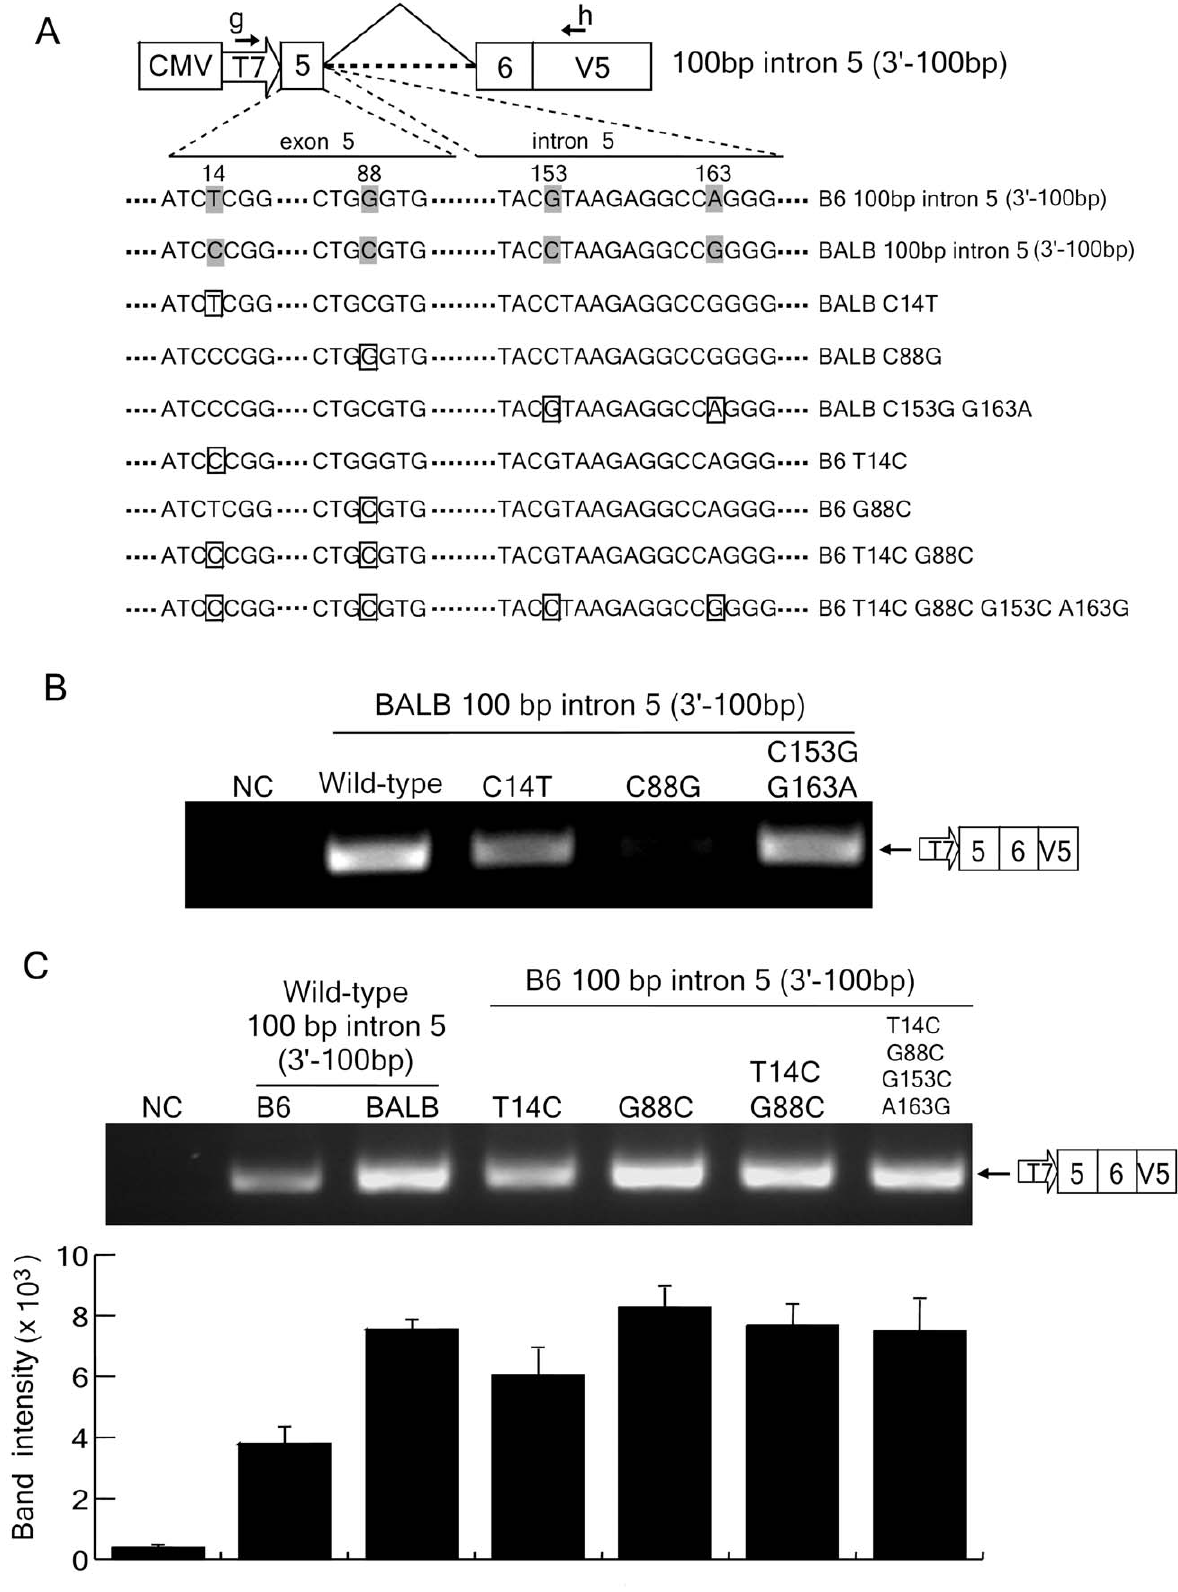
Figure 6. Identification of critical residues for exon 5 inclusion into mA3 mRNA. (A) Polymorphic nucleotides indicated with the shades were exchanged at the boxed sites between the B6 and BALB/c alleles. The numbers 14, 88, 153, and 163 above the shown nucleotide sequence are base numbers from the first nucleotide of exon 5. (B and C) The results of splicing assays performed with the plasmids depicted in (A). The predicted splicing product is shown on the right side of each panel. Band intensities are averages of 3 independent RT-PCR reactions with SD. doi:10.1371/journal.ppat.1002478.g006 PLoS Pathogens |